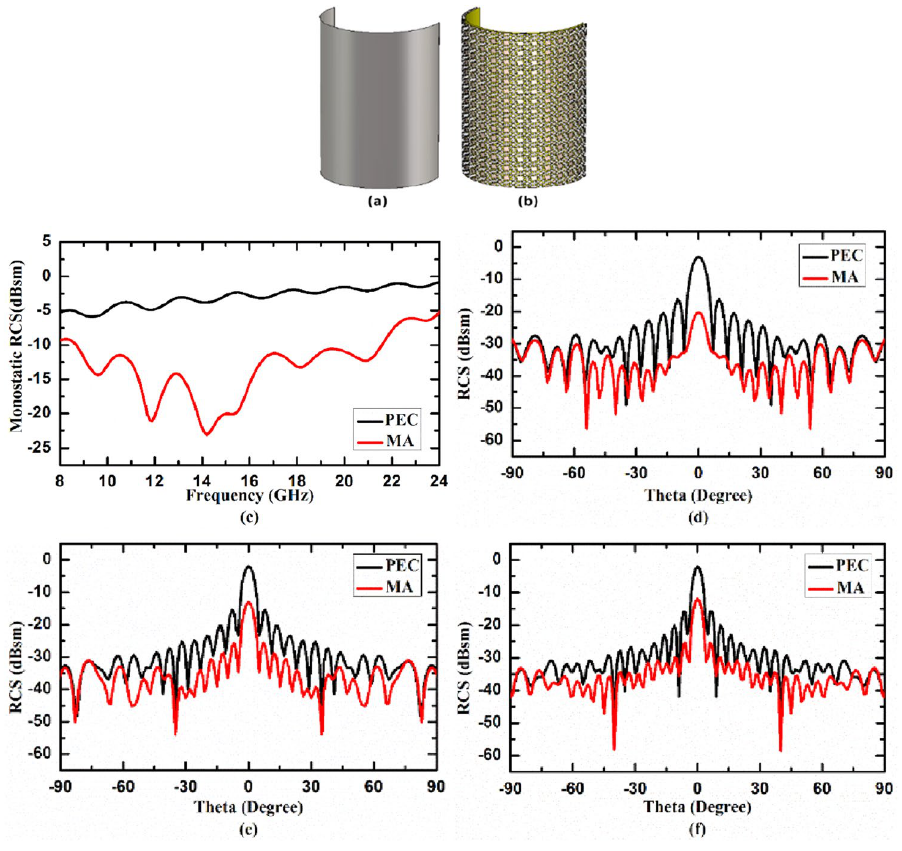
Figure 9. 3D view of cylindrically bent ( a ) PEC and ( b ) MA with radius of curvature 50 mm, ( c ) monostatic RCS, and bistatic RCS at ( d ) 14.84 GHz, ( e ) 17.99 GHz, ( f ) 21.14 GHz under normal